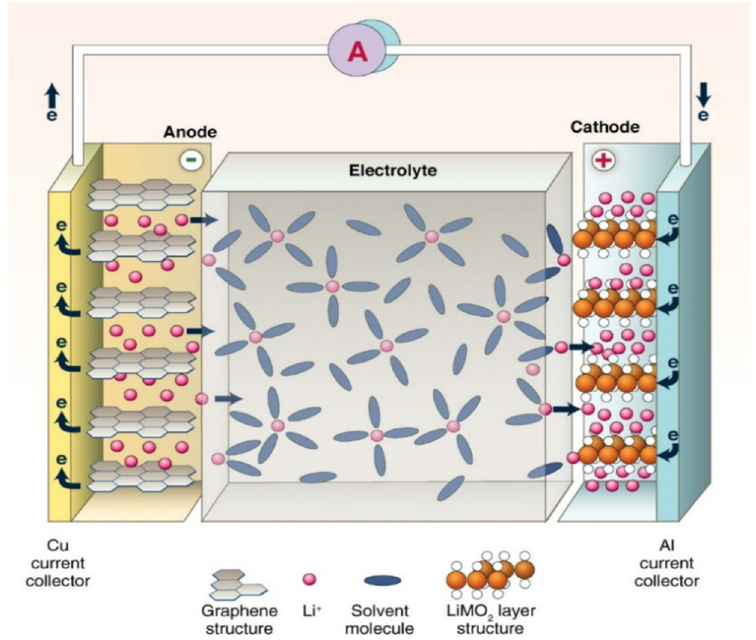
Figure 6. Schematic diagram of the Li-ion cell operation.